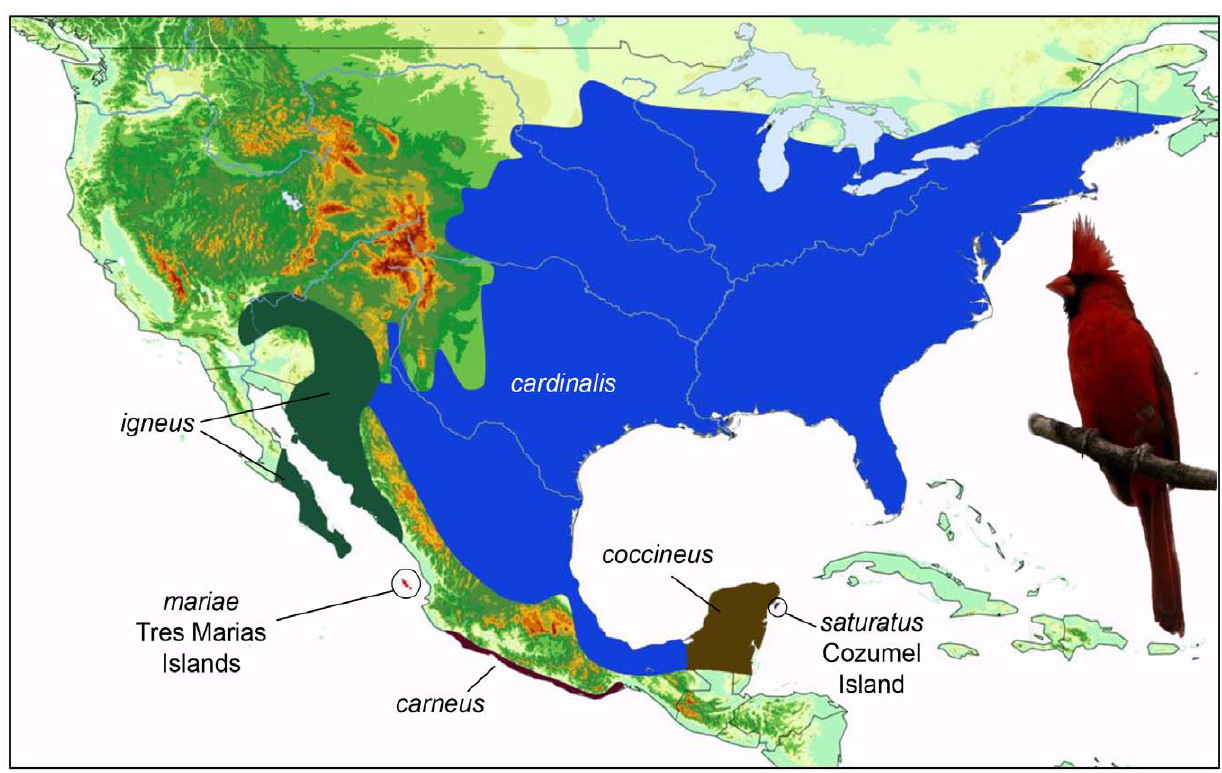
Figure 1. Range map of the Cardinaliscardinalis lineages. Approximate distributions of mainland and island C. cardinalis lineages. An image of a male C. cardinalis igneus is